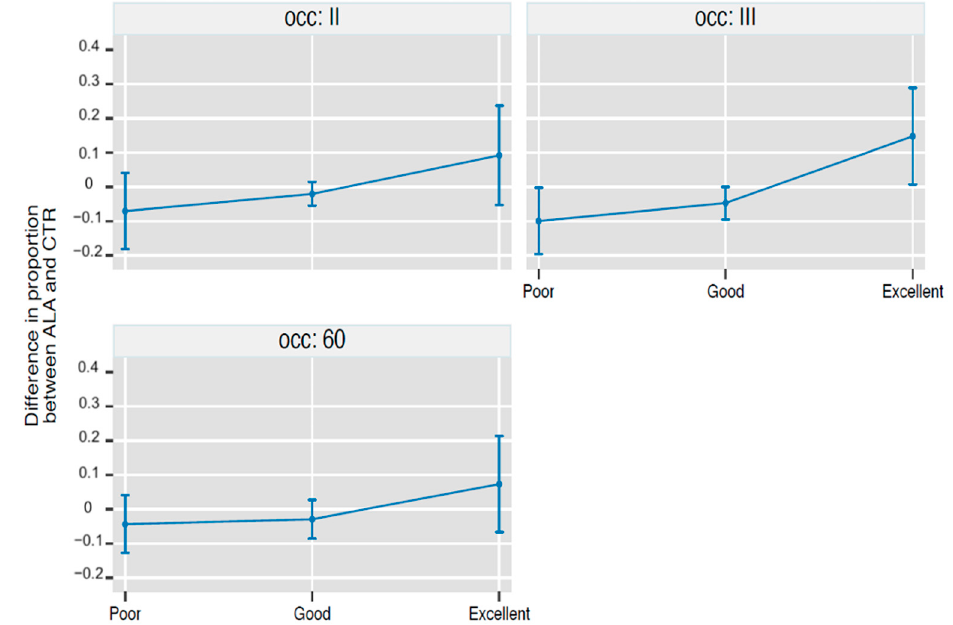
Figure 3. Between-group (control O 2 -O 3 group and O 2 -O 3 + ALA group) difference in the proportion of patients with a poor, good, and excellent outcome during the study after 2nd treatment (OCC: II), after 3rd treatment (OCC: III), and at the clinical check-up conducted 60 days ± 8 from the end of the treatment (OCC: 60). Values are proportions and 95% cluster confidence intervals from ordinal logistic regression with Bonferroni correction for 9 contrasts. Points whose 95% CI do not cross the 0 line, i.e., all points at occasion III, are significant at p -level < 0.05 (see statistical analysis for details).